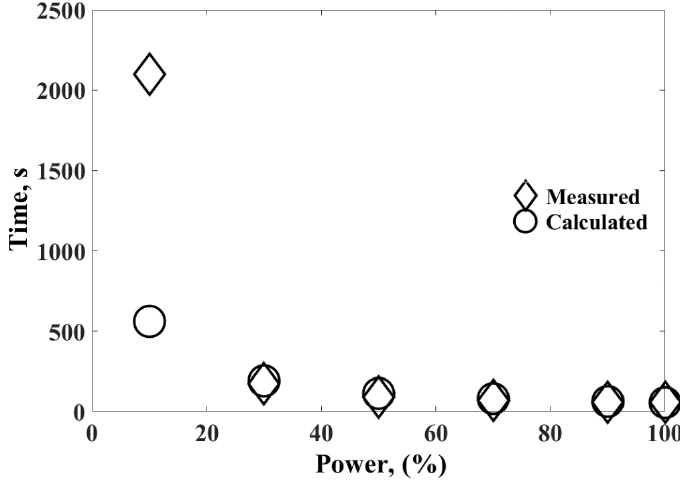
Figure 5. Effect of microwave power on time to reach the temperature of 100 °C for a water sample of v = 100 cm 3 .